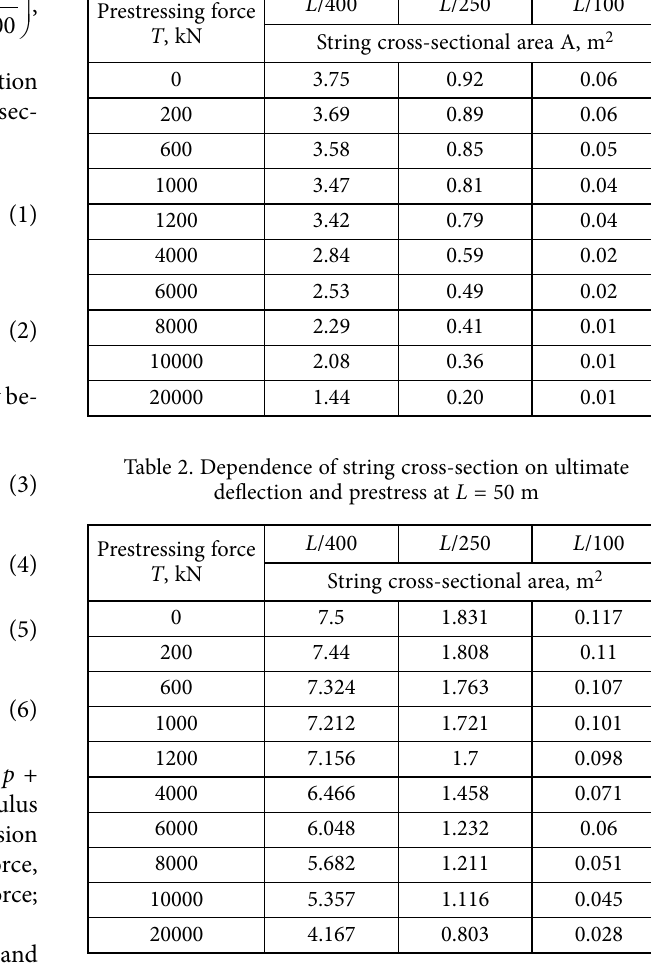
Table 3. Relative difference in string cross-sections when the spans L = 50 and L = 25) L /400 L /250 L /100 Prestressing force The ratio of the cross-sectional areas of T , kN the string where span lenght L = 50